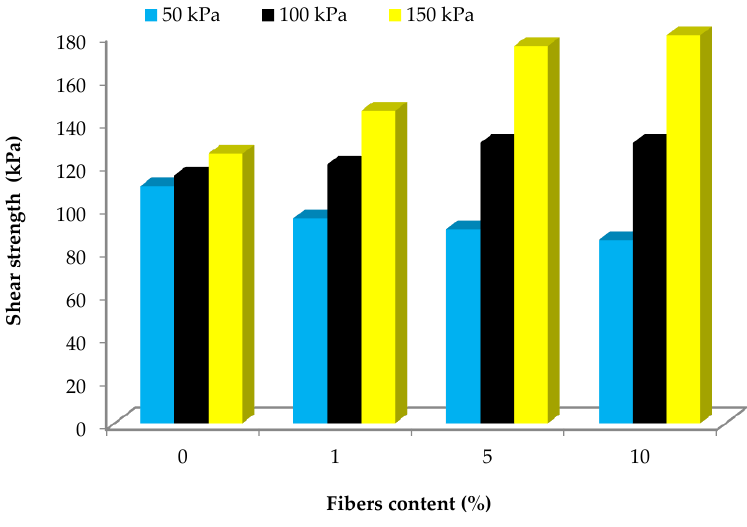
Figure 11. Stress-strain plot of soil treated at different Diss fiber rates.